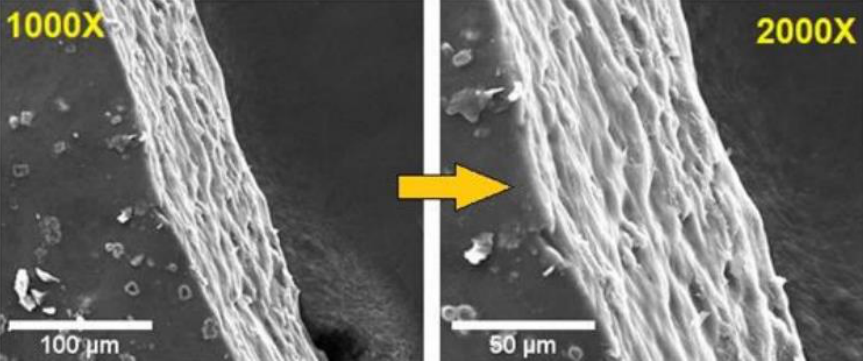
Figure 7. SEM images of the films loaded with amikacin [157].